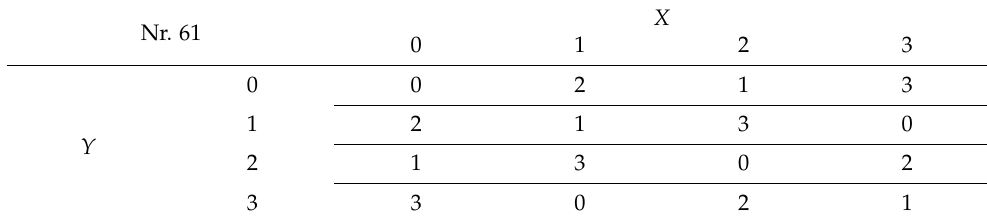
Table 1. The quasigroup table.